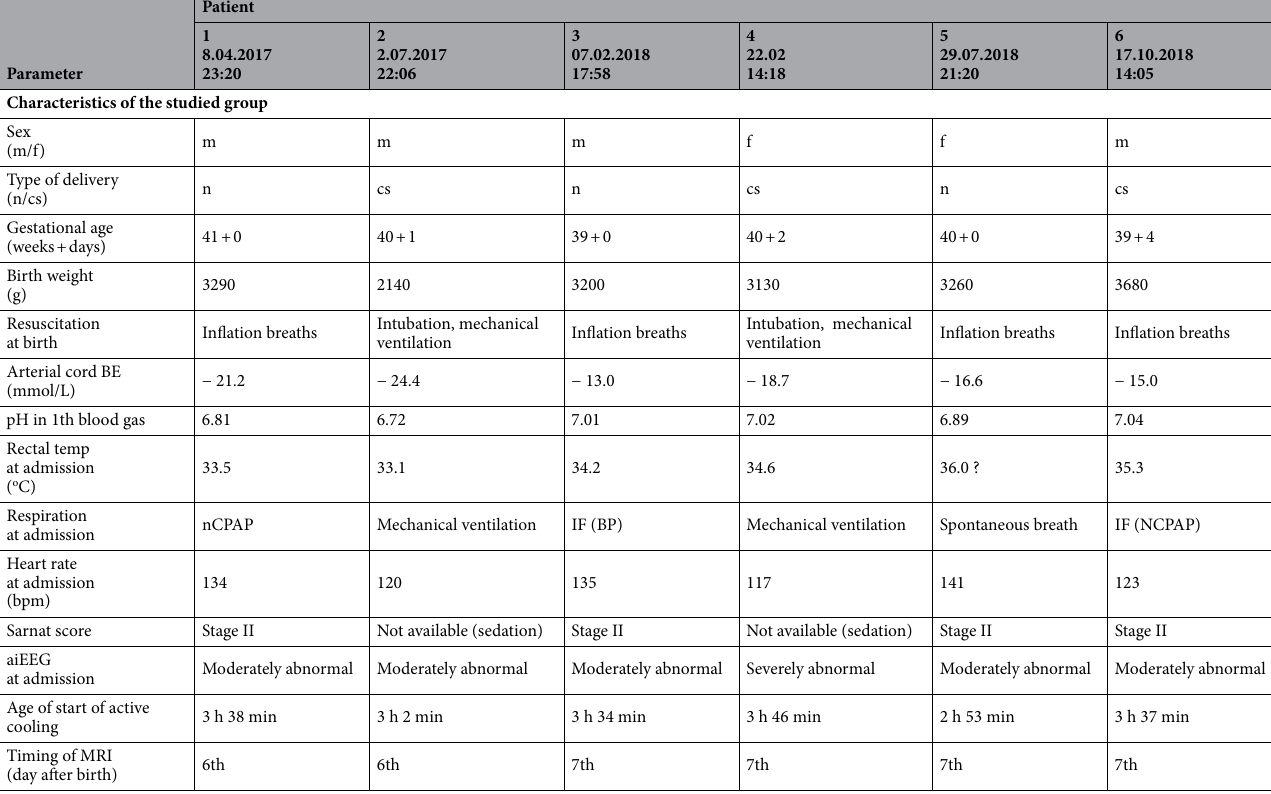
Table 1. Characteristics of the studied group. m male, f female, n natural, cs caesarean section, bpm beats per minute, IF (BP) Infant Flow